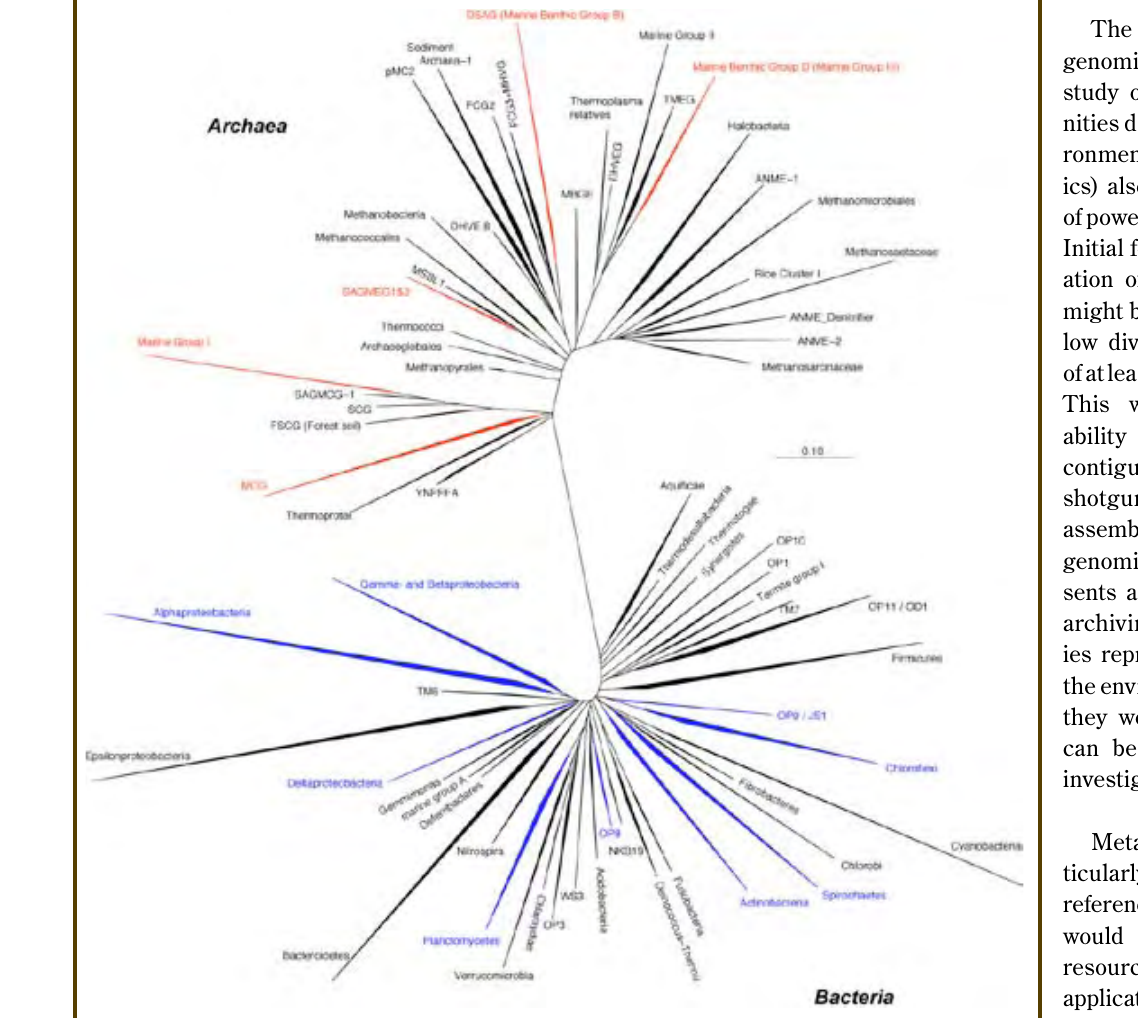
Figure 2. Phylogenetic tree of the domains Archaea and Bacteria based on 16S rRNA gene sequences. Red and blue lines respectively represent branches of archaea and bacteria that have been frequently detected in deep subseafloor sediments. The scale bar indicates the expected number of changes per nucleotide positions. Sequence data were analyzed with the ARB software package (Ludwig et al.,